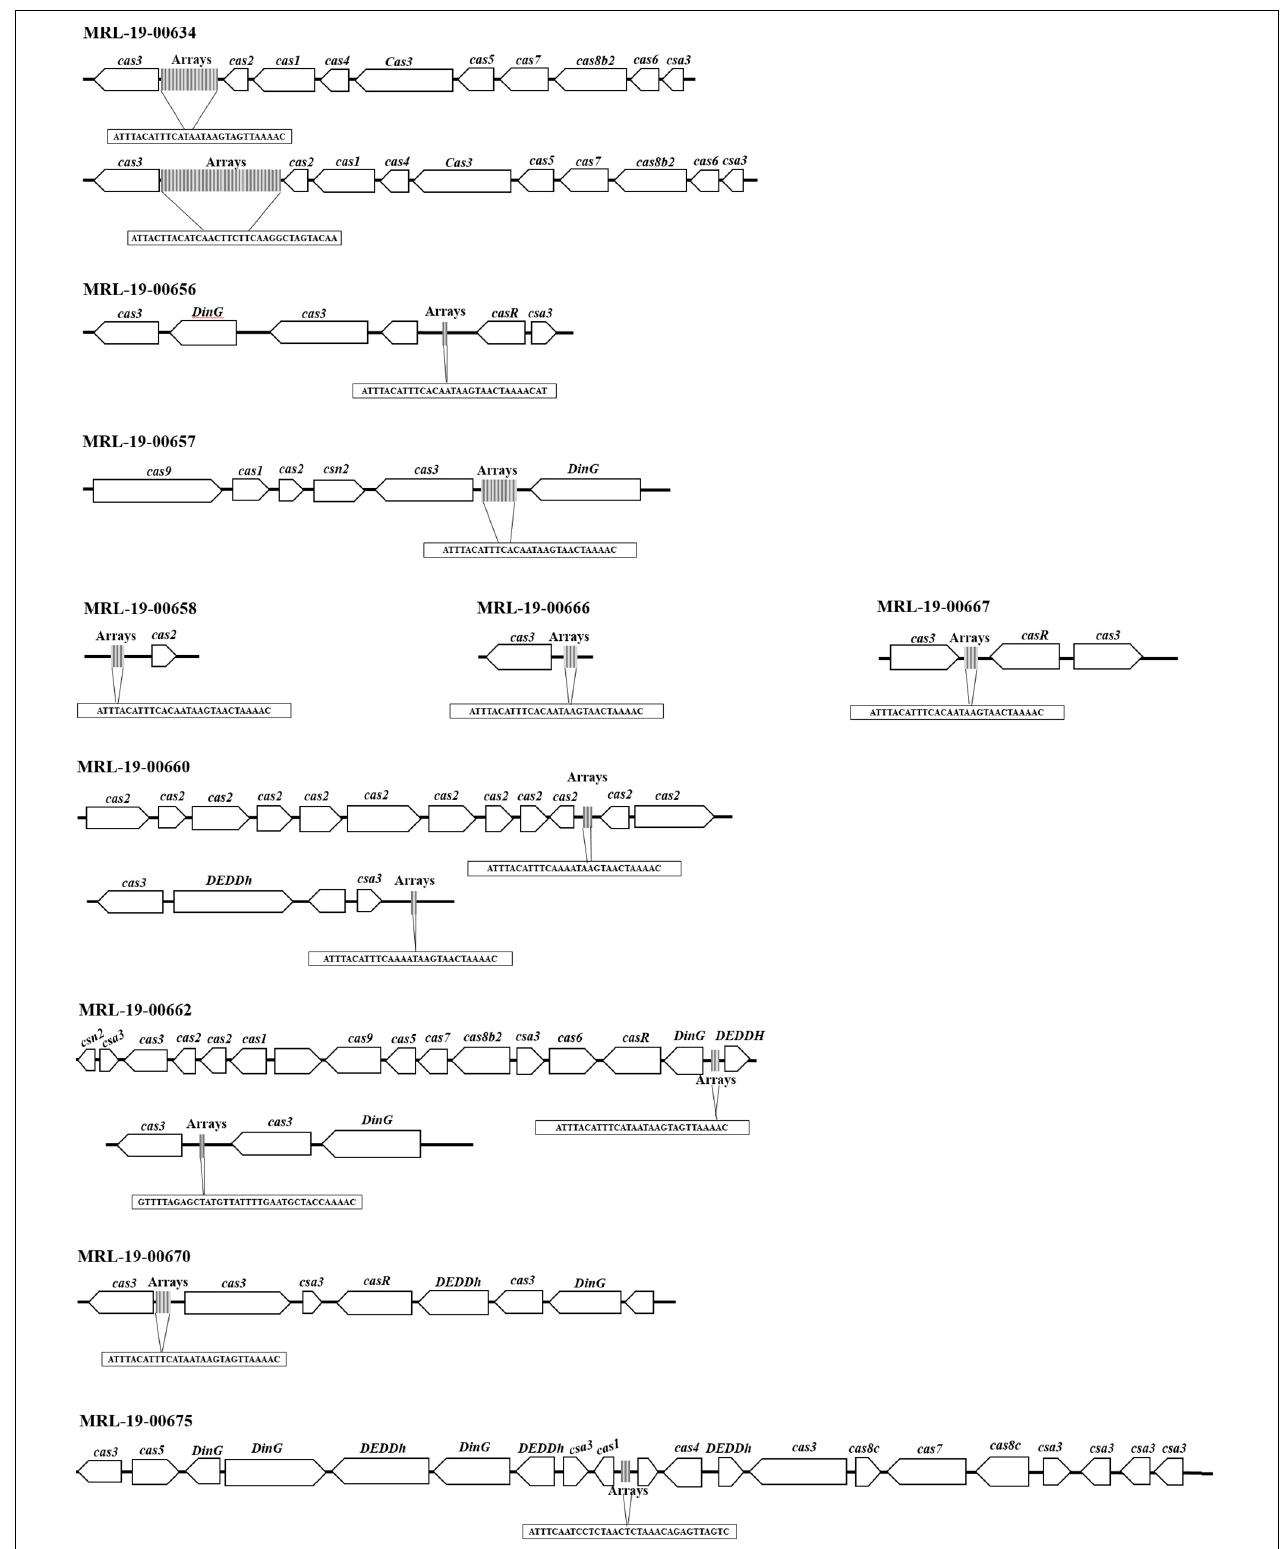
FIGURE 3 | CRISPR-Cas systems identified in L. monocytogenes genomes. The identified systems belong to the CRISPR-Cas type II-B system, and some genomes show more than one array.